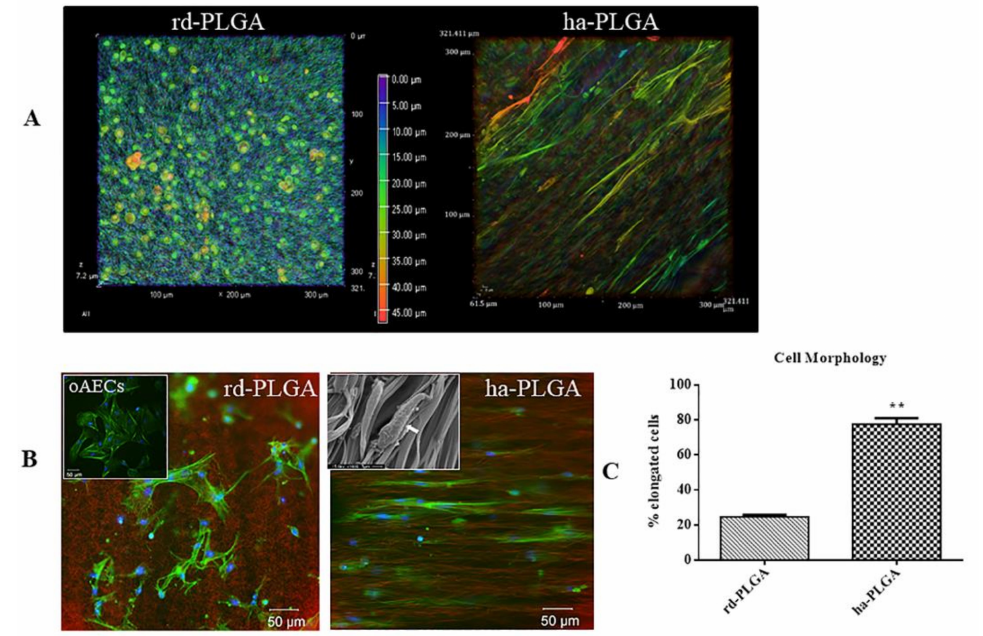
Figure 4. oAEC distribution and morphology on ha-PLGA and rd-PLGA fleeces. ( A ) Representative XY confocal images of oAEC distribution within rd-PLGA and ha-PLGA fleeces after 48 h culture. The depth-coded MaxIP option was used to assess cell penetration within the fleeces by defining the gradient color related to the direction of the cells within the fleece. The gradient scale shows in purple the most superficial surface of the fleece, whereas in red the bottom surface. It is evident that oAECs are optimally distributed within the fleeces, especially in ha-PLGA where there are some blue cells. ( B ) Representative images of oAEC morphology evidenced with phalloidin stain (green fluorescence) and nuclei counterstained with DAPI (blue fluorescence), where it is evident that, in rd-PLGA fleeces, cells retain their typical cobblestone morphology, whereas they acquire an elongated tenocyte-like morphology after 48 h culture on ha-PLGA fleeces. The inset in the ha-PLGA image shows an example of an SEM microphotograph where the fusiform morphology of the cells attached on the aligned fibers is evident (white arrow). Fleeces captured from bright field exposition were inverted and combined in the image as red channel. Scale bar = 50 µ m. In the insert an example of oAEC morphology at time 0 cultured on a Petri dish. Scale bar = 50 µ m. ( C ) Quantification of the percentage of the elongated oAECs after 48 h seeding on rd-PLGA and ha-PLGA fleeces ** Statistically significant values between rd-PLGA and ha-PLAGA fleeces ( p < 0.01). (n = 3 for each type of fleece / analysis), sca ff old size: 15 mm × 7